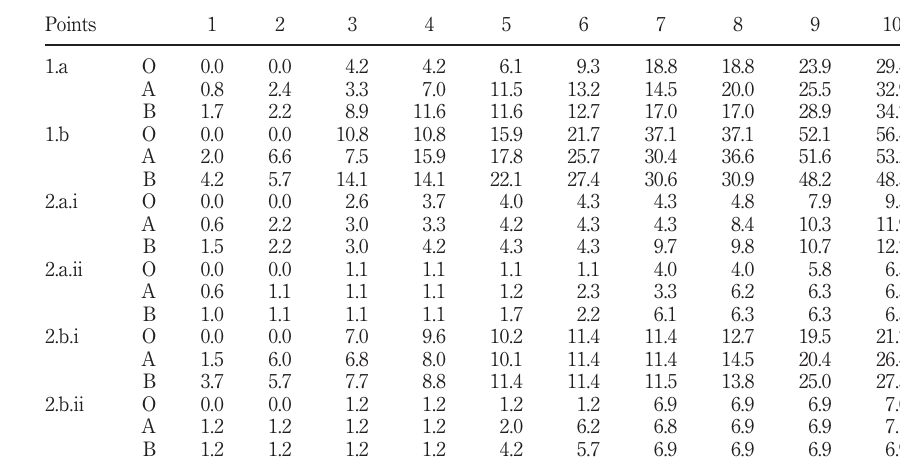
Table II. First natural frequencies v 1